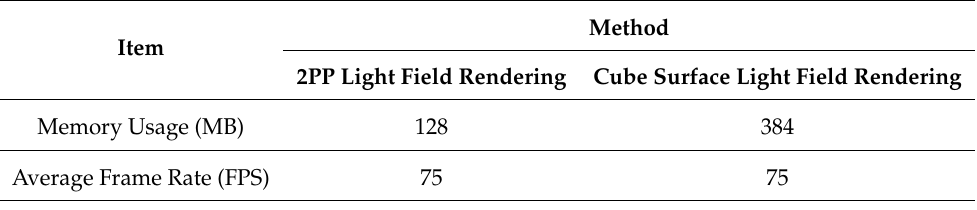
Table 1. Comparison of memory usage and frame rate between our method and the 2PP light field.